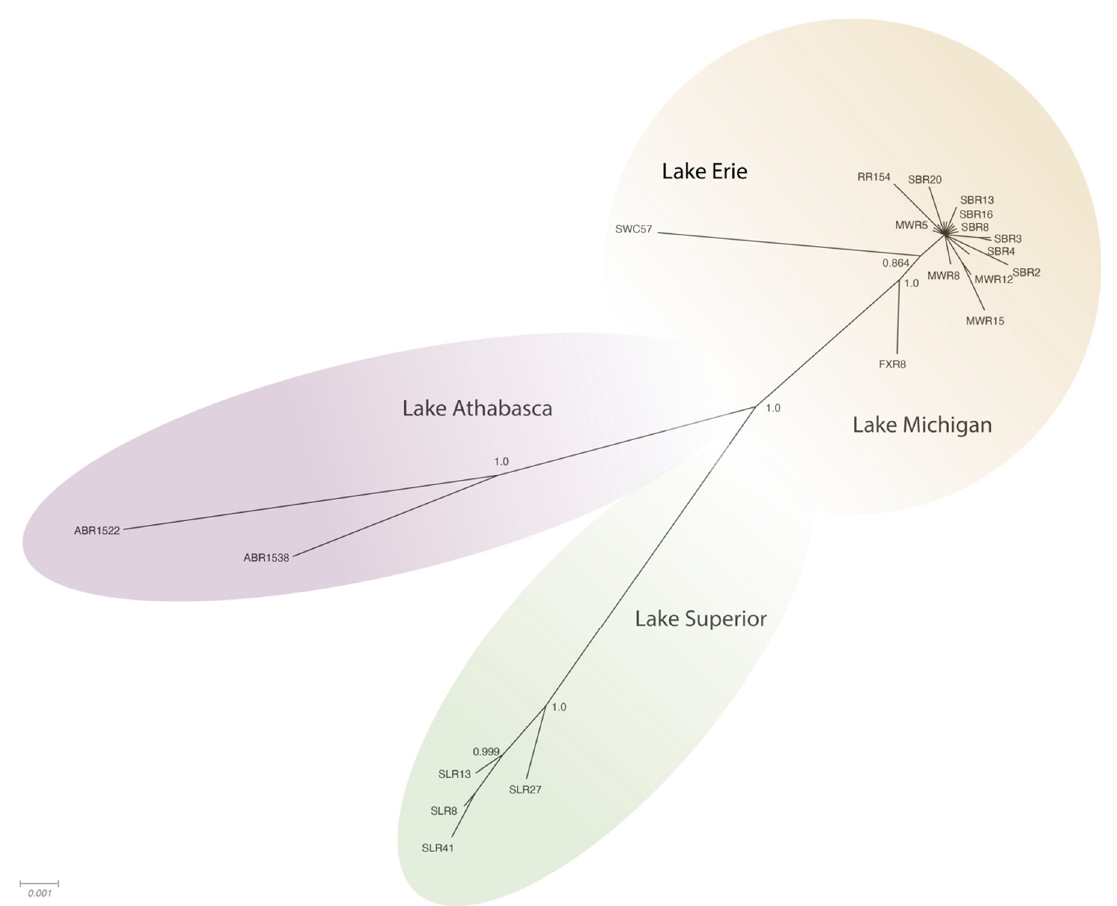
Figure 4. Radial phylogram depicting the relationships of concatenated protein sequences (P, C and S) from 27 complete genomes (3541–3543 nt) of WSHBV isolated from white suckers inhabiting tributaries of the Great Lakes or the Athabasca River in Alberta Canada. Results are from Baysian analysis. Branches are labeled with posterior probability and color-coded by dominant clades. Isolates were tributaries of Lake Athabasca (Athabasca River, ABR) Lake Superior (St. Louis River, SLR); Lake Erie (Swan Creek, SWC) and Lake Michigan (Fox River, FXR; Milwaukee River, MWR; Sheboygan River, SBR and Root River, RR).